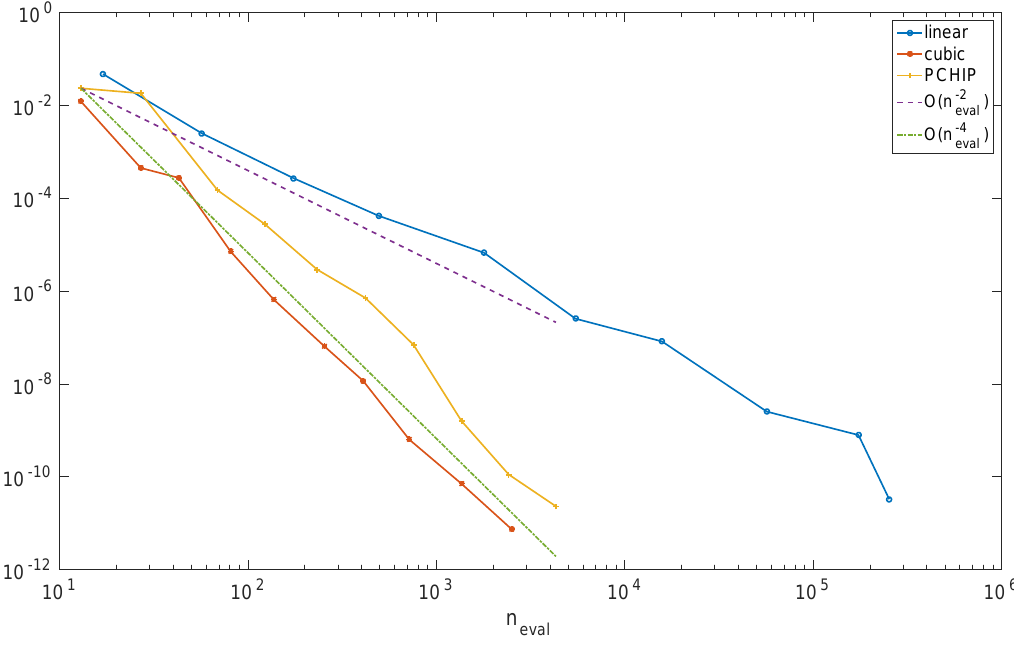
Fig. 3 In continuous line, the graphics of k v 15 − ˆ v 15 k ∞ as a function of n eval for ε k = ε varying from 10 − 1 to 10 − 10 , applied to each local rule and f 1 . For comparison, in discontinuous line are shown the growth rates O ( n − 2